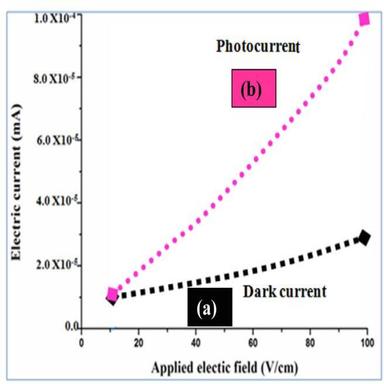
Photoconductivity of CdO-SnO2 nanocomposite material. Applied field (V Cm-1 ) Vs electric current (mA) (a) Dark and (b) photocurrent on irradiation with 100 W halogen lamp.